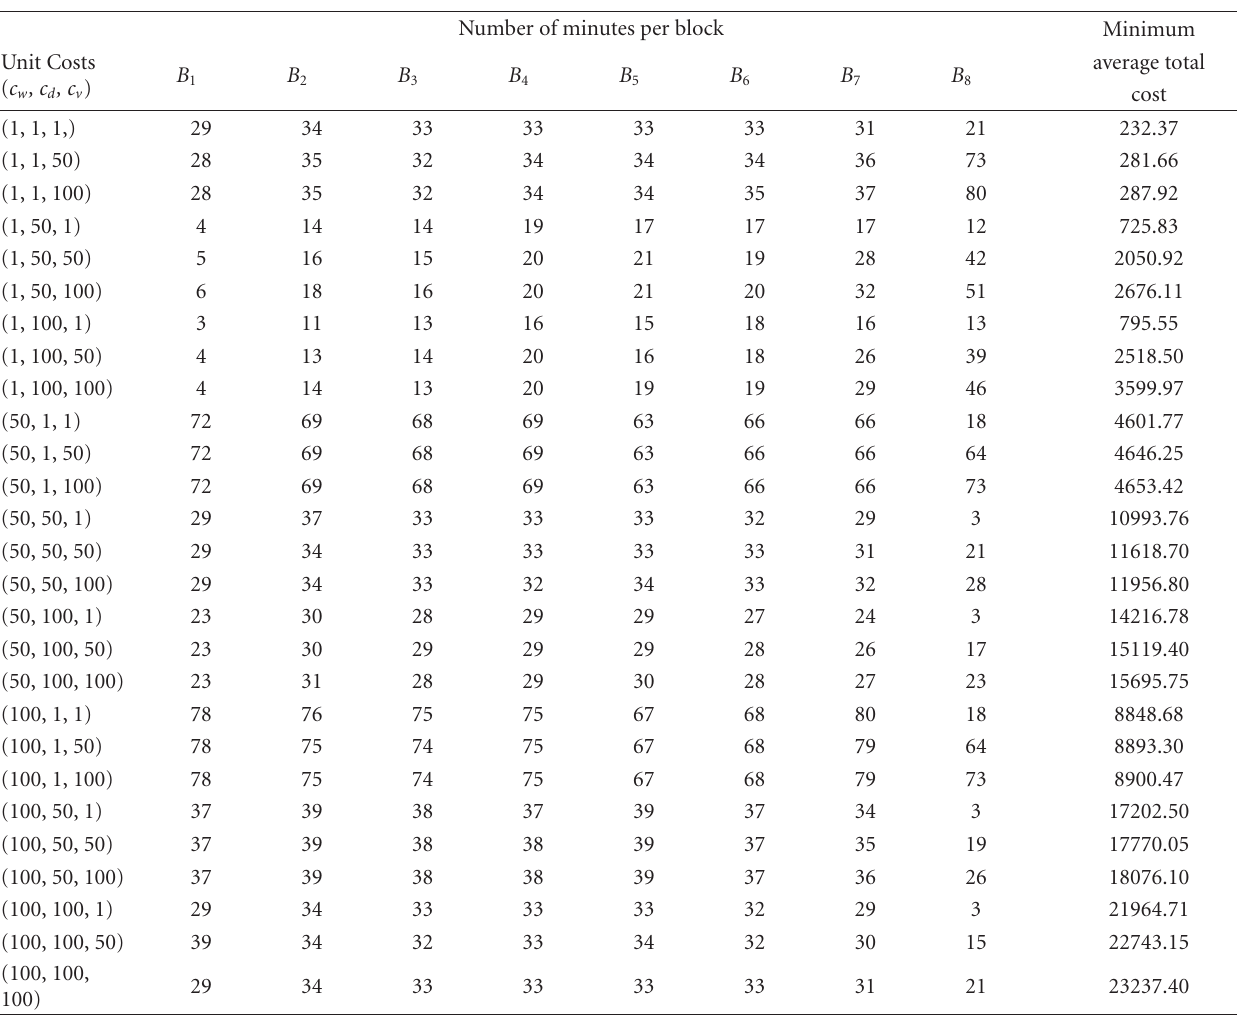
Table 1: Results for [2 2 2 2 2 2 2